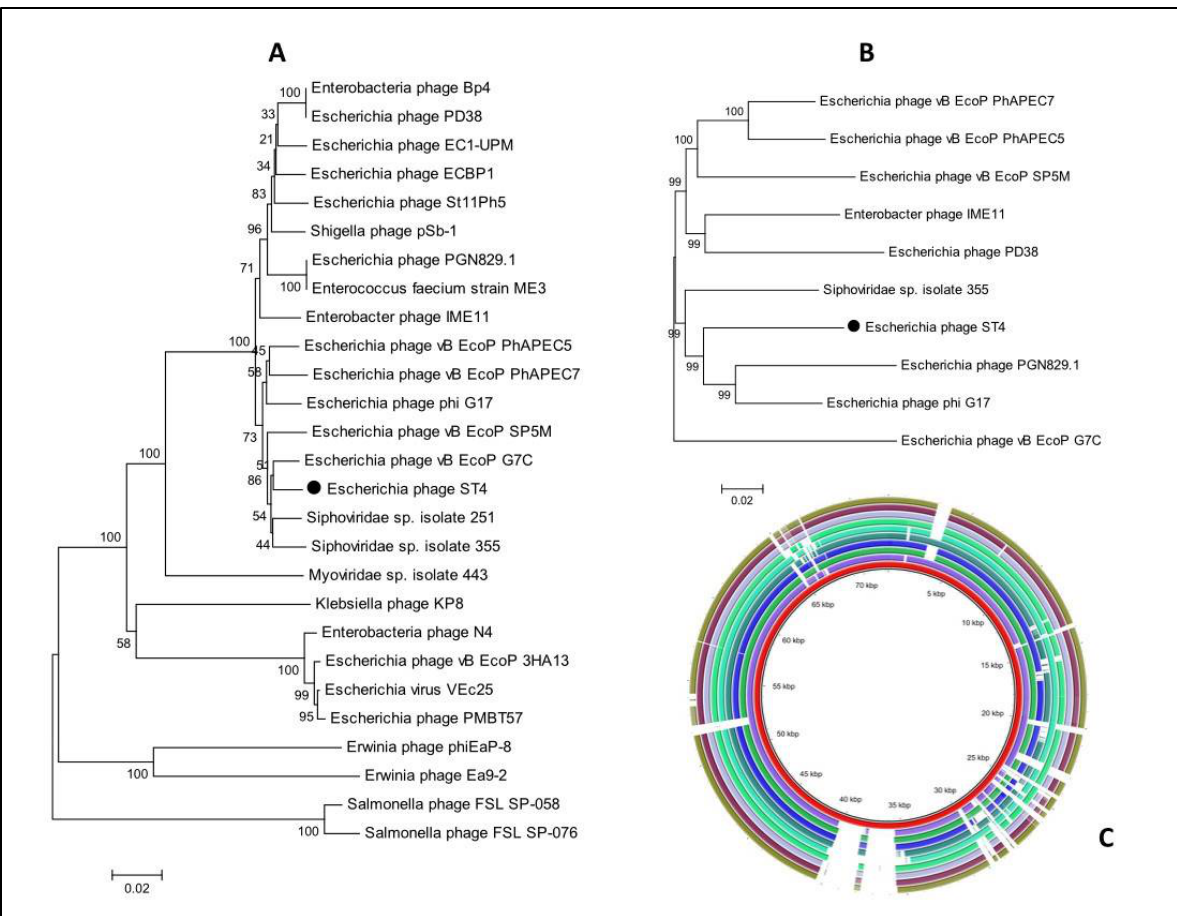
Figure 11. ( A ) phylogenetic tree of Escherichia phage ST4 based on the sequence of terL gene, ( B ) shows the phylogenetic GBDP tree and ( C ) genome comparisons with the closest phages obtained from the NCBI GenBank using BRIG software version 0.95.